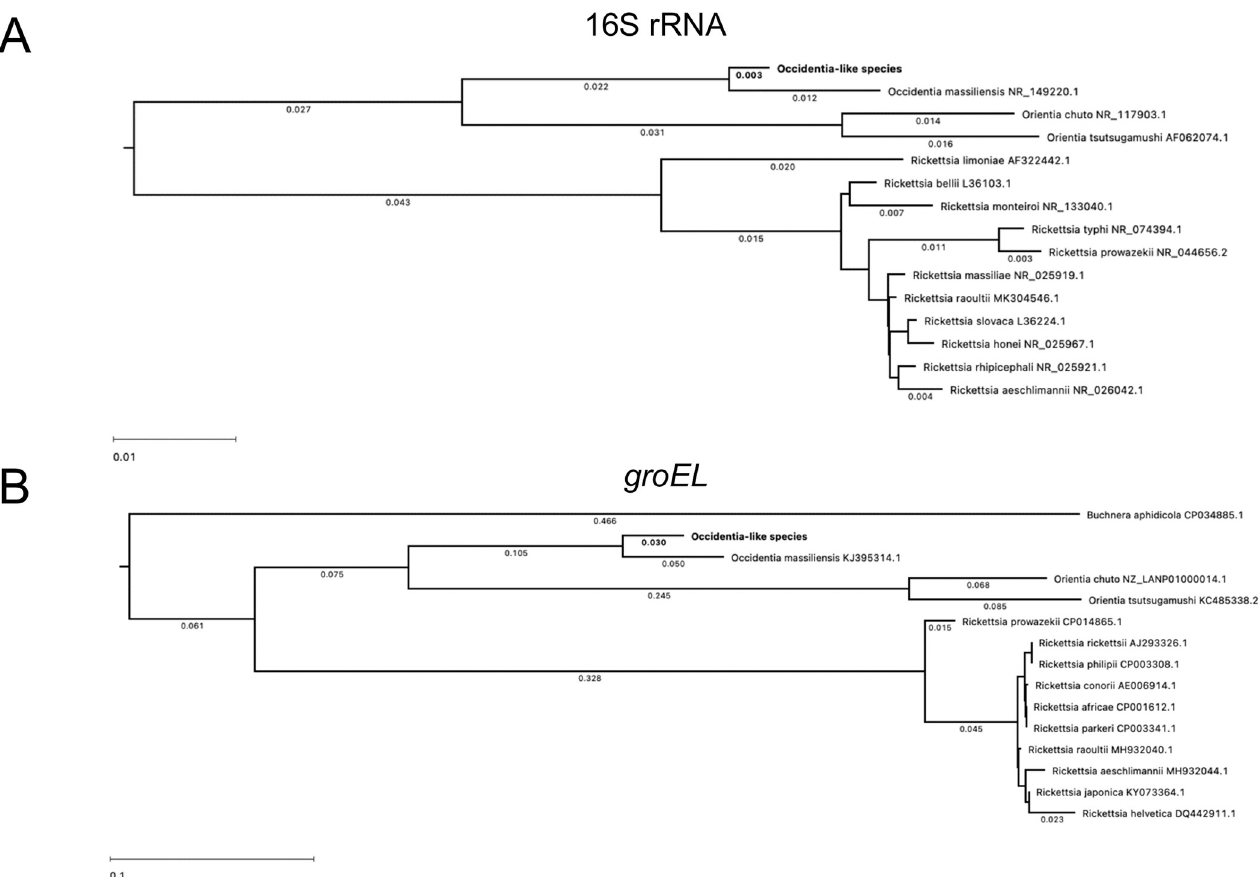
Fig 3. Phylogenetic analysis of Occidentia -like species 16S rRNA gene and groEL genes nucleotide sequences with other rickettsial bacteria. Phylogenetic trees showing relatedness of Occidentia -like species 16S rRNA (A) and groEL (B) with Occidentia massiliensis , Orientia chuto , Orientia tsutsugamushi , Buchnera aphidicola and other Rickettsia spp. is shown. MAFFT (v6.240) was used as the method for multiple sequence alignment and RAxML (v8.2.12) was used to construct the phylogenetic tree. GenBank accession numbers are provided along with the species names.